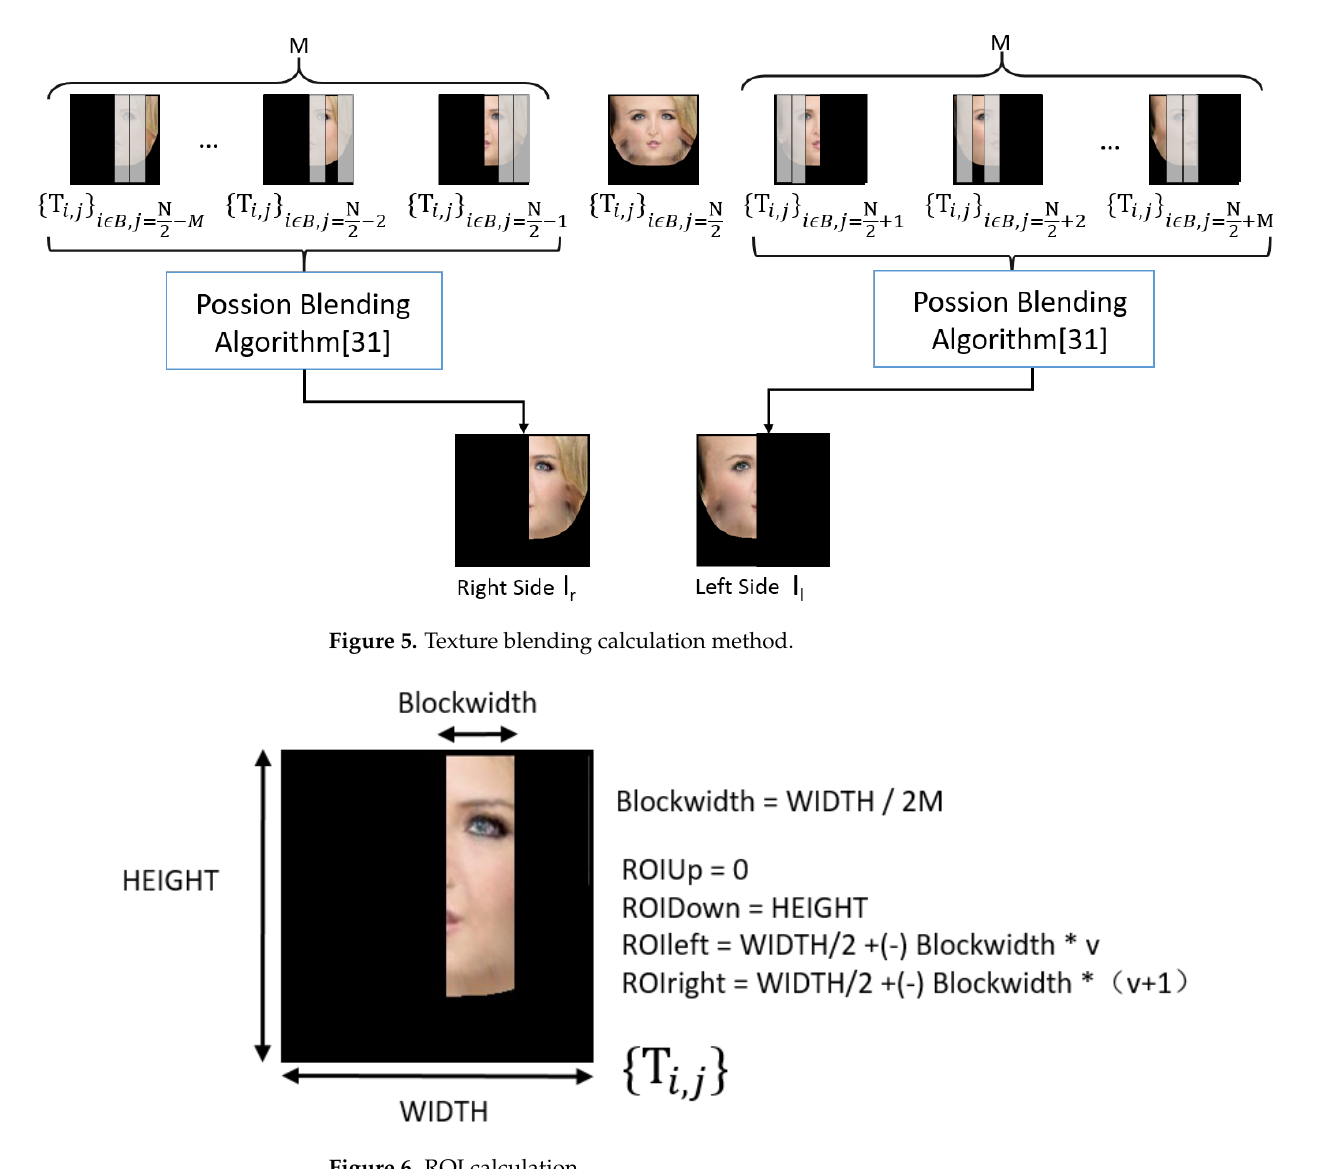
Figure 6. ROI Figure 6. ROI calculation. Algorithm 1: Blending Panoramic Texture for Each Identity